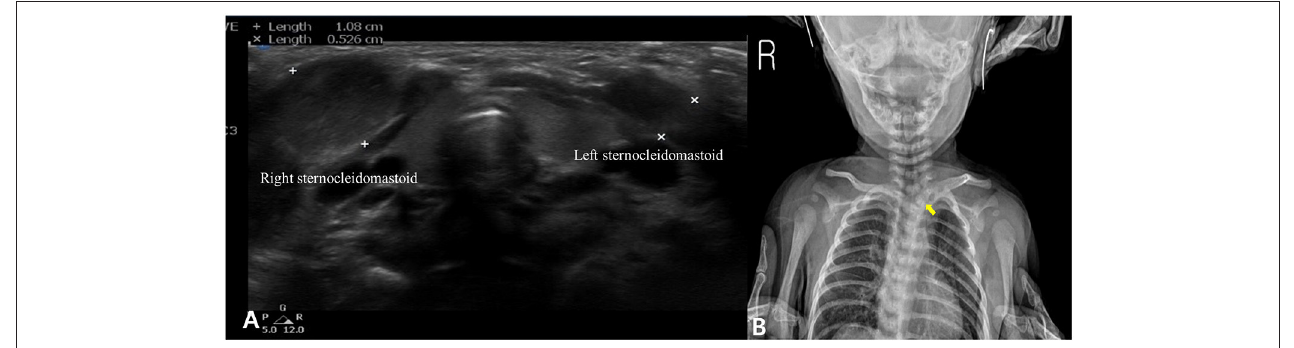
FIGURE 1 | Ultrasonography showing diffuse enlargement and hyperechoic findings in the right sternocleidomastoid muscle (A) . A congenital vertebral anomaly was suspected in the clavicle X-ray imaging (yellow arrow) (B) .